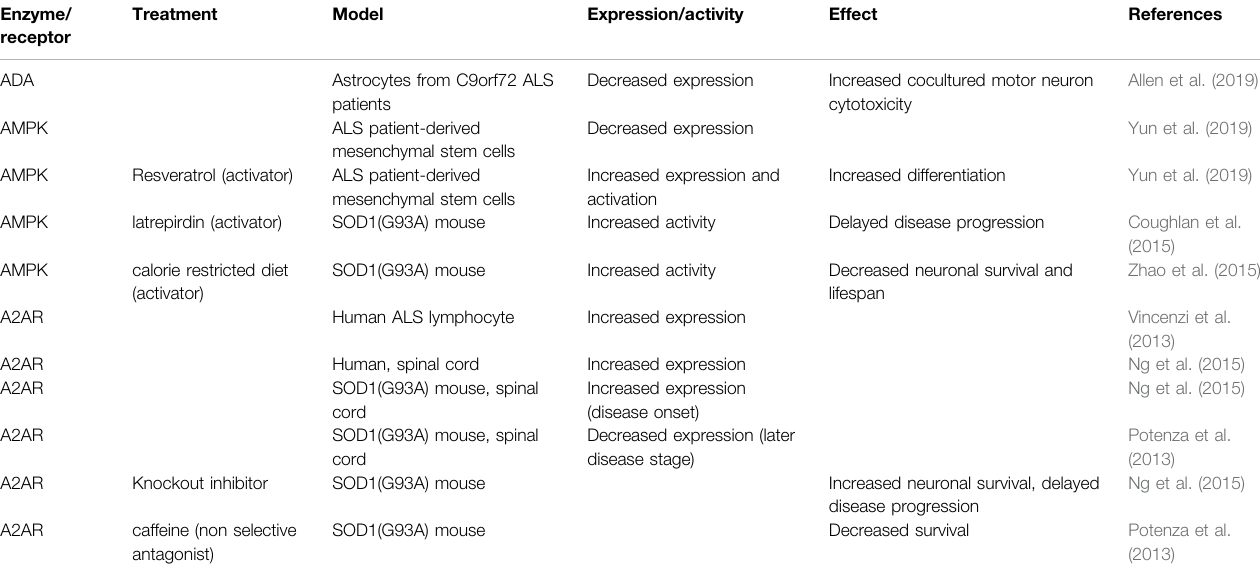
TABLE 2 | Involvement of adenosine metabolism enzymes and receptors in